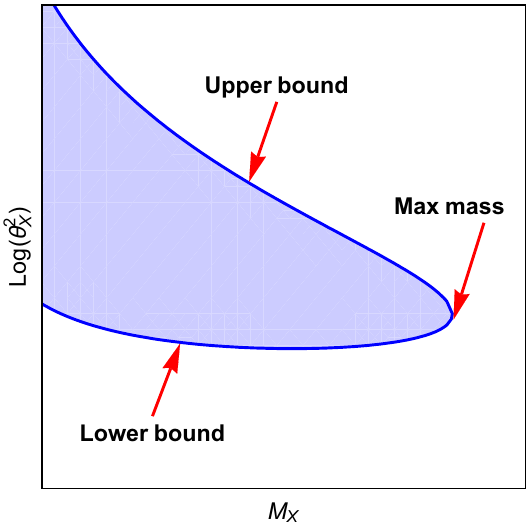
l target-det , i.e. particles do not reach the ∼